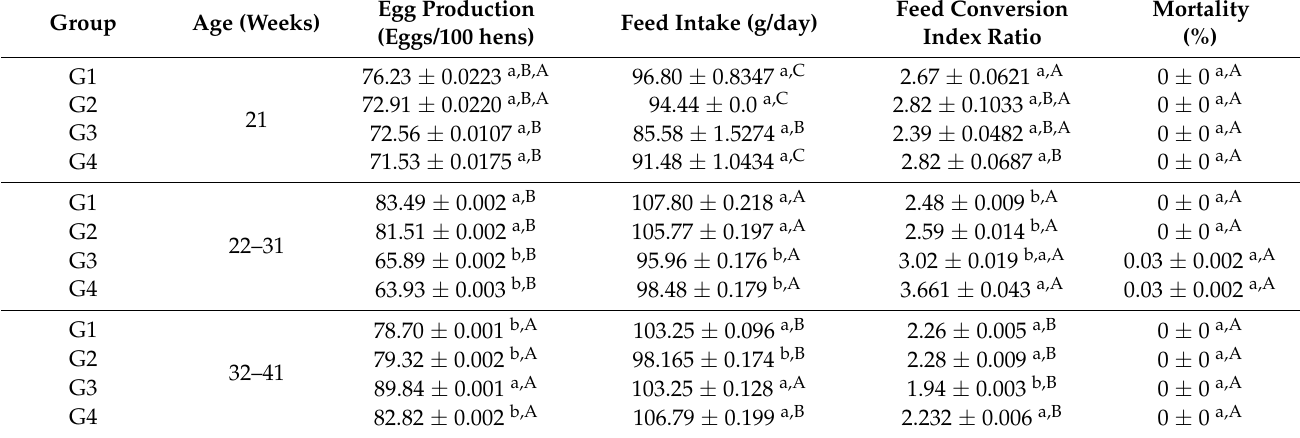
Table 1. Productive parameters of Salmonella challenged and unchallenged laying hens with or without Allium -based phytobiotic